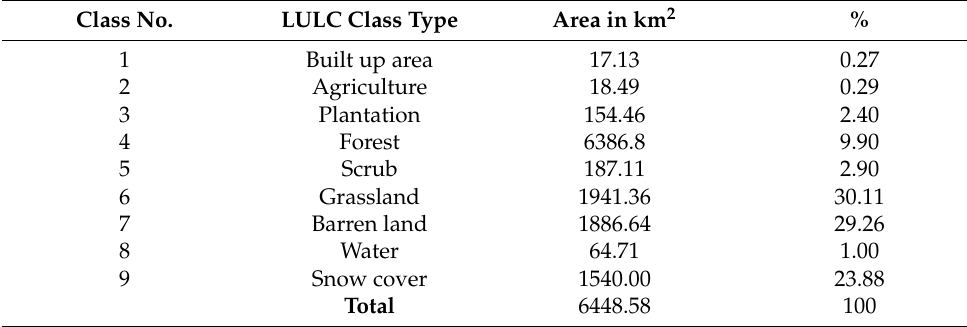
Table 2. LULC classes and their percentage of the geographical area in 2018. Class